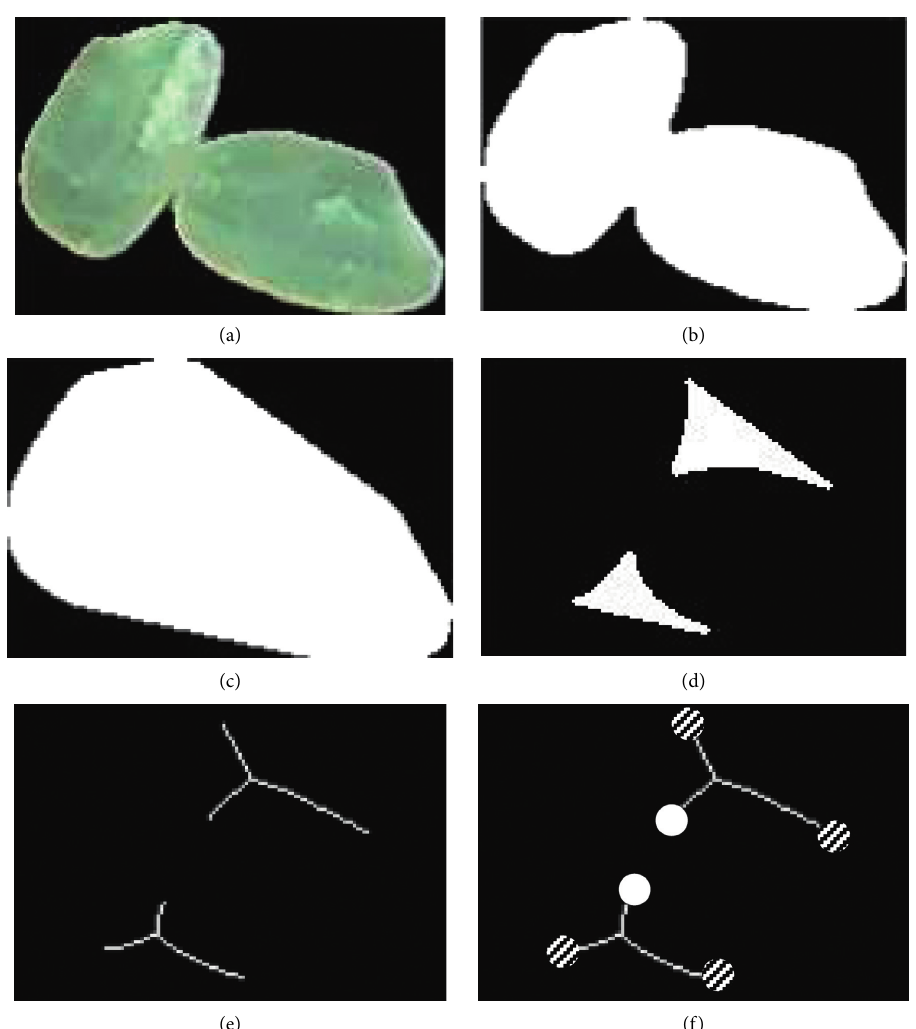
Figure 5: Schematic diagram of feature segmentation endpoints. (a) Original image. (b) Binary image. (c) MCH. (d) Background image. (e) Skeleton image. (f) Skeleton